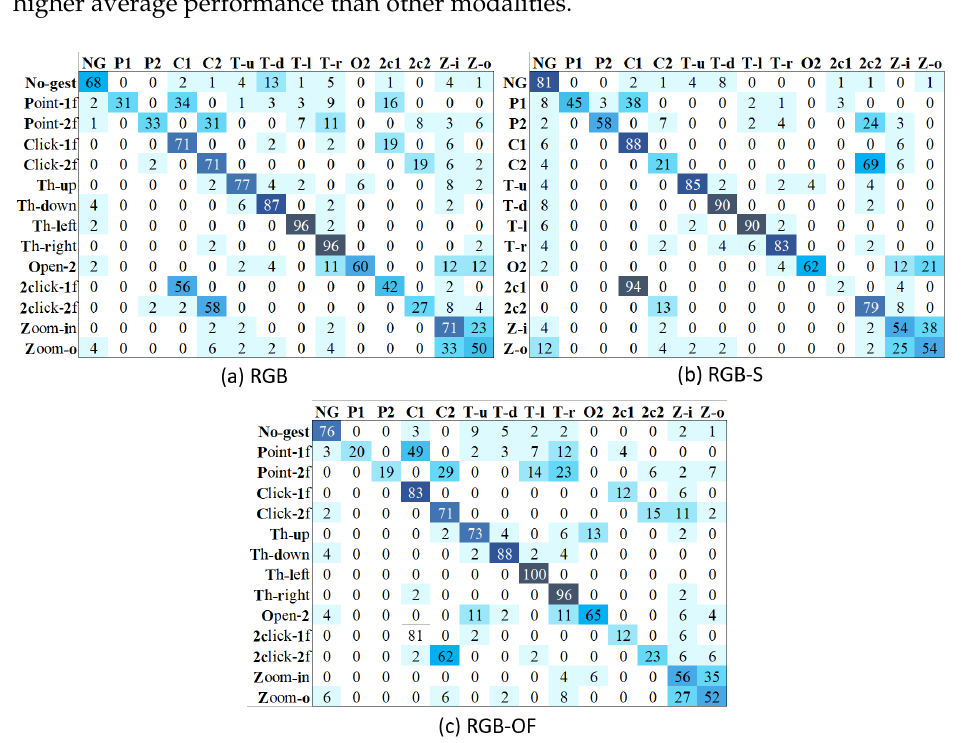
Figure 9. Confusion matrices of TSM with different input